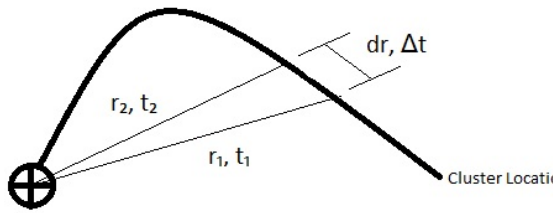
Fig. 8. Illustration of the time lag methodology for calculating the perturbation travel time from the magnetosphere to the